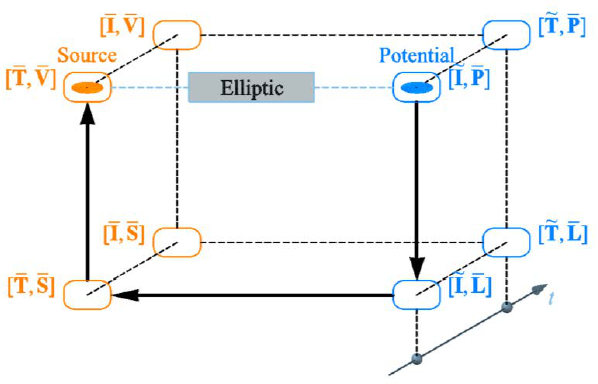
the circumcenter of each triangle lies inside the triangle.